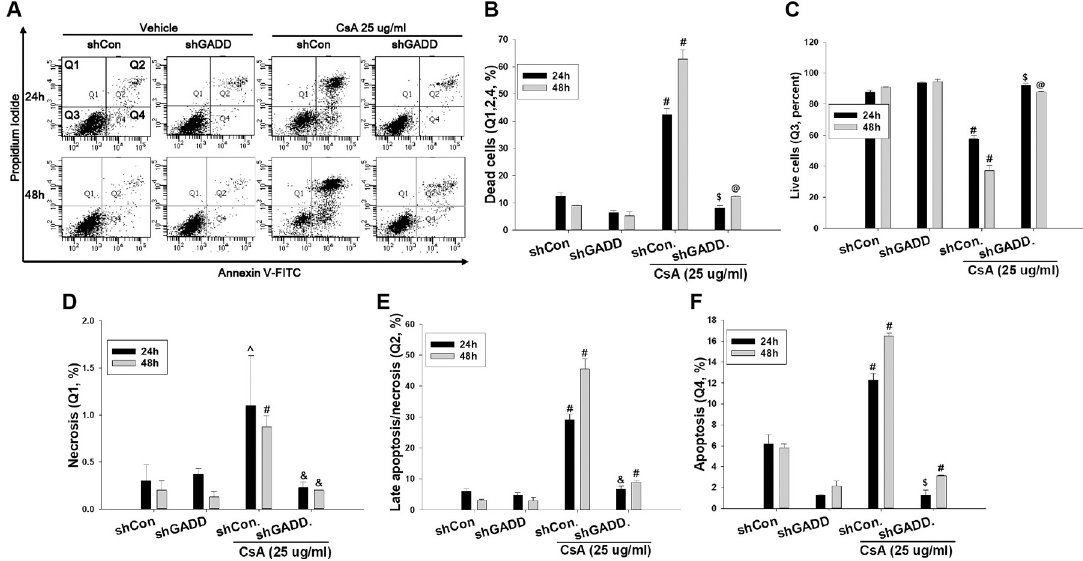
Fig 6. Quantification of apoptosis and necrosis by flow cytometry in CsA-treated HRE cells: Effect of GADD45G knockdown. shGADD and shCon stable HRE cells were treated with 25 μ g/ml CsA for the indicated time periods. (A) Representative scatter plots of flow cytometry. Quantification of (B) dead cells (Q1+Q2+Q4), (C) viable cells (PI negative and Annexin V negative, Q3), (D) necrotic/ non-viable cells (PI positive and Annexin V negative, Q1) (E) late apoptotic/necrotic cells (PI positive and Annexin V positive, Q2), and (F) early apoptotic cells (PI negative and Annexin V positive, Q4). Each bar represents mean ± SD of 3 experiments. One-way ANOVA followed by Bonferroni’s post-hoc comparisons tests was used to compare groups. A p value < 0.05 was considered significant. #p < 0.05 vs. all other corresponding groups; &p < 0.05 vs. corresponding shCon/CsA groups; @p < 0.05 vs. corresponding shGADD and shCon/ CsA groups; $p < 0.05 vs. corresponding shCon and shCon/CsA groups. shGADD represents shRNA constructs to knockdown GADD45G; shCon, control shRNA constructs targeting no known genes.